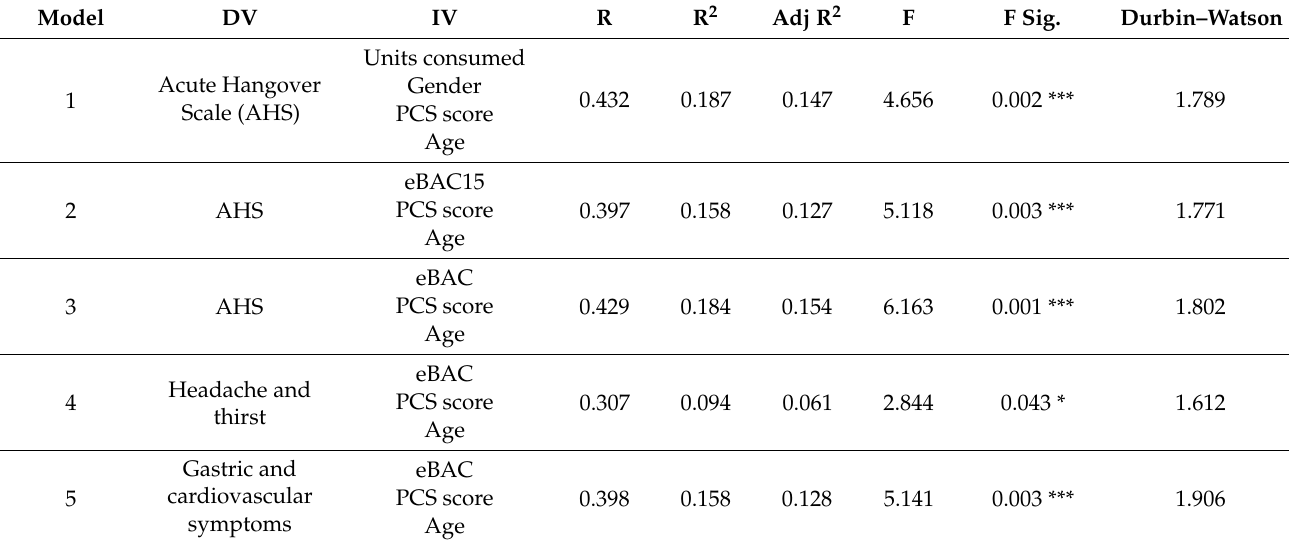
Table 5. Summary of model statistics for regression